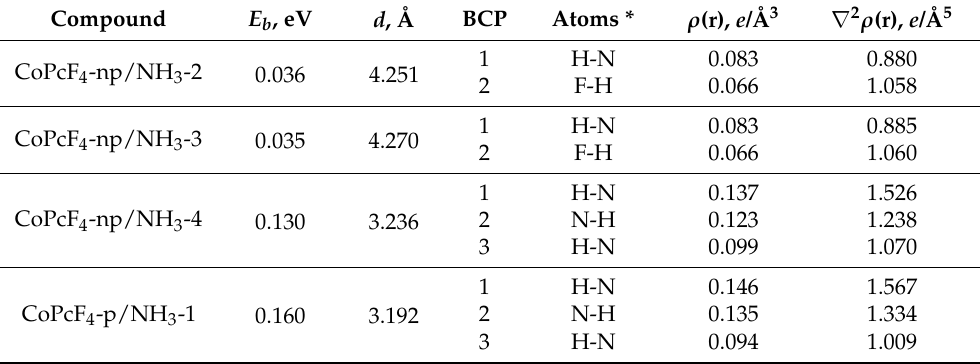
Table 2. The interaction parameters of the NH 3 molecule with cobalt phthalocyanines.